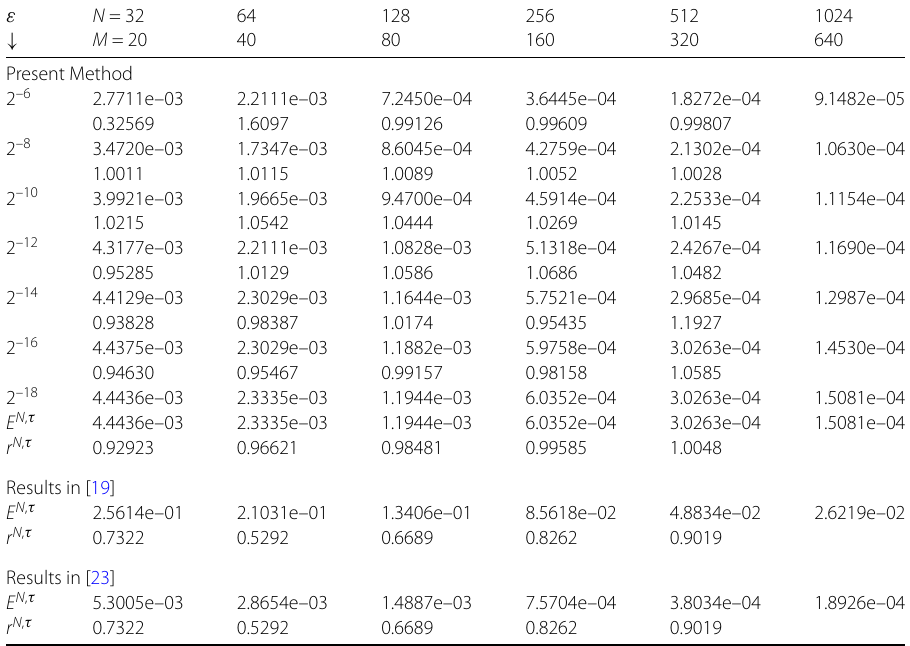
Table 3 E N , τ ε , E N , τ , and r N , τ for Example